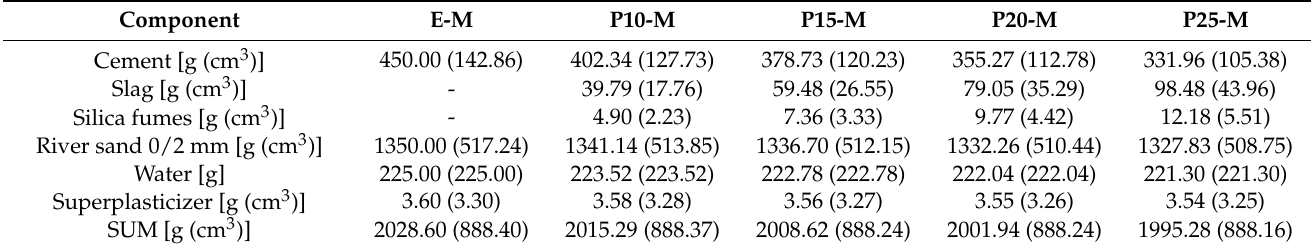
Table 2. Mix proportion of mortar for one series of samples.